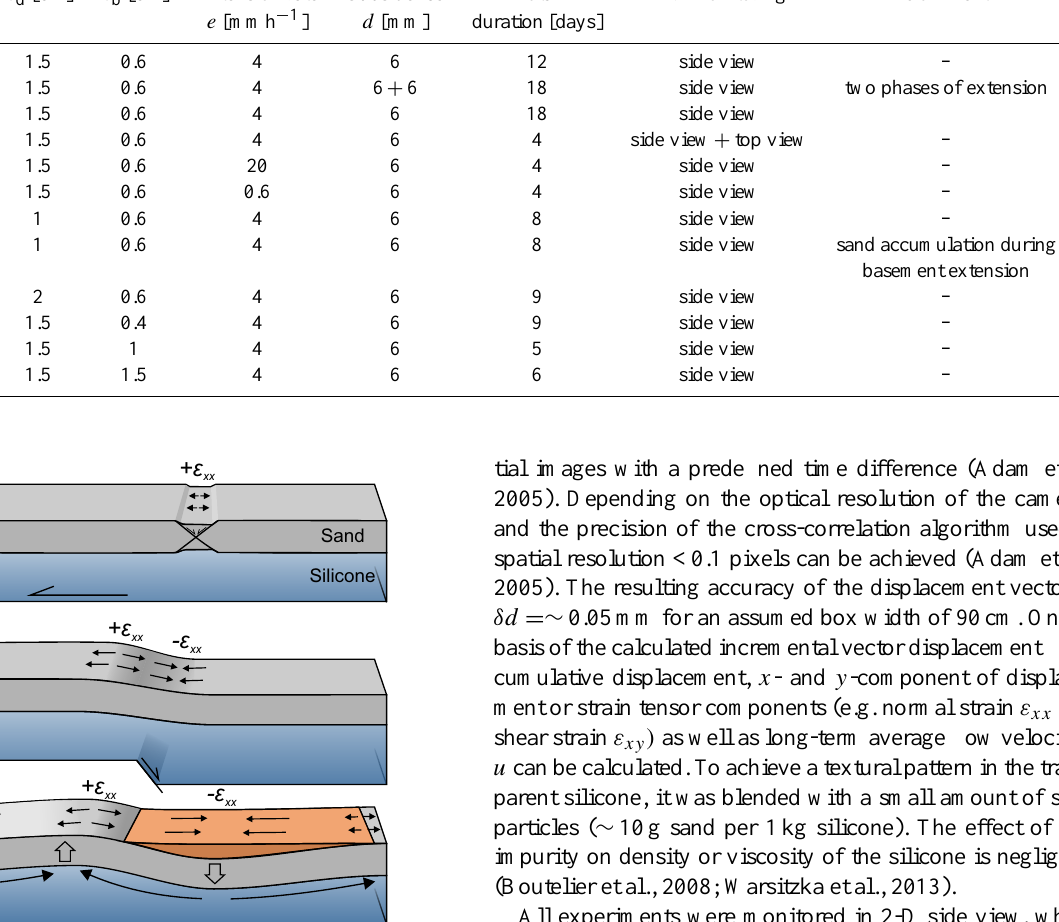
Table 2. Experiments and key parameters, where h d is the thickness of the ductile silicone and h b the thickness of the brittle sand cover. Experiment